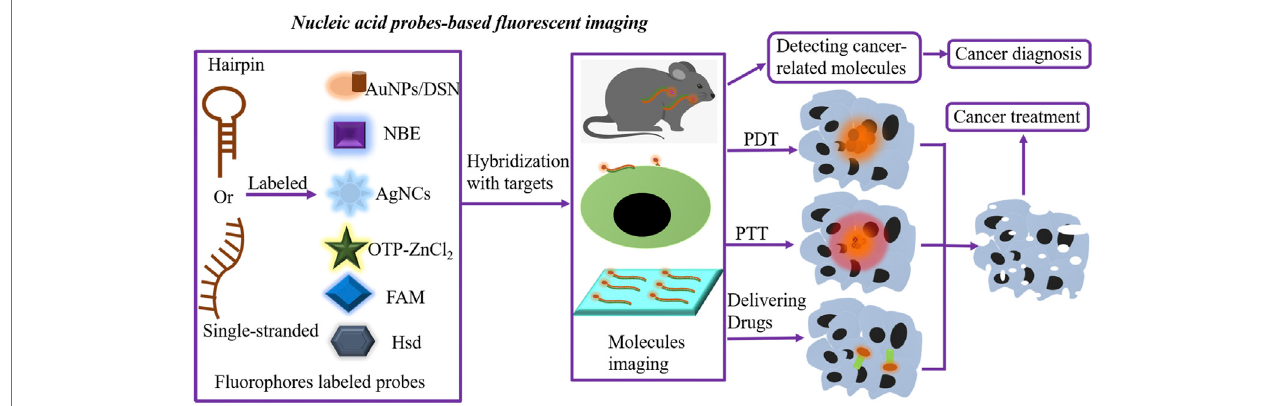
FIGURE 2 | Nucleic acid probe – based fl uorescent imaging. Hairpin or single-stranded nucleic acid probes are labeled with fl uorophores to form nucleic acid probe – based fl uorescent imaging platforms. Novel fl uorophores include AuNPs/DSN, AgNC-MBs, FAM, OTP-ZnCl 2 , Hsd, and NBE. In the presence of targets, fl uorophore-labeled probes hybridize targets, further performing molecular imaging and locating molecules expressed on the surface of cells or tissues and targeting cancer cells in living samples. The fl uorescent imaging platforms can detect cancer-related molecules, resulting in an elevated ef fi ciency of cancer diagnosis. Meanwhile, these imaging methods are utilized for delivering anticancer drugs and guiding PDT and PTT, further killing cancer cells by in situ imaging of low-abundance biomarkers. AgNCs, silver nanoclusters; AuNPs, gold nanoparticles; MBs, molecular beacons; DSN, double-speci fi c nuclease; PDT, photodynamic therapy; PTT, photothermal